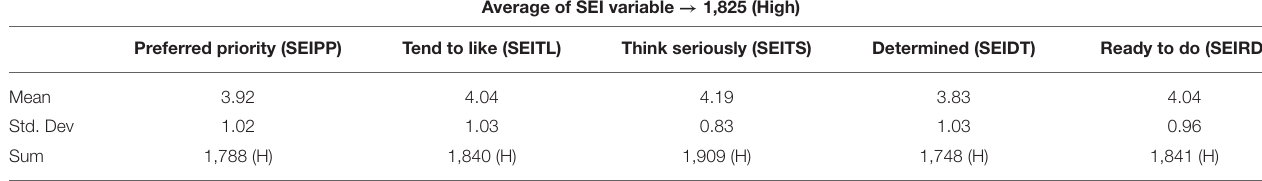
TABLE 7 | Descriptive analysis of SEI perception.